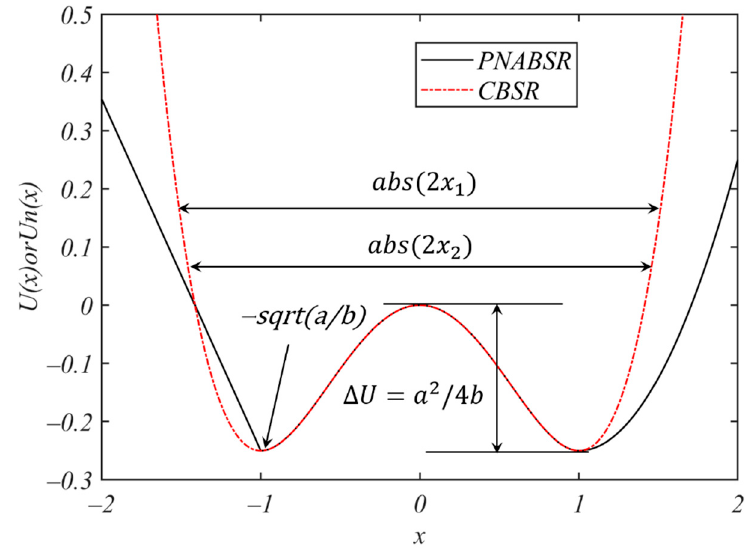
Figure 2. Potential function of PNABSR and CBSR models.